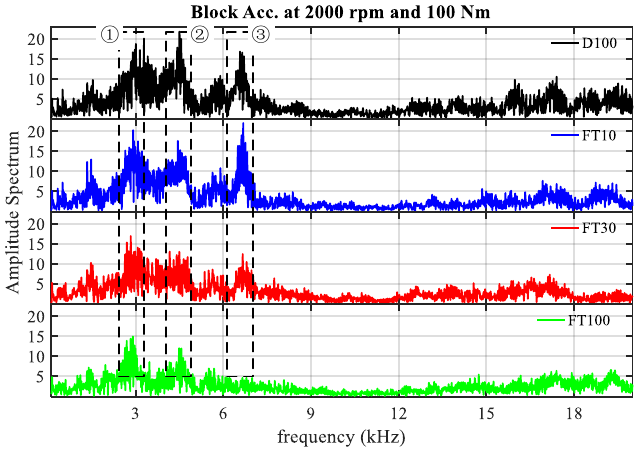
Figure 10. Frequency domain curve of engine block vibration acceleration.